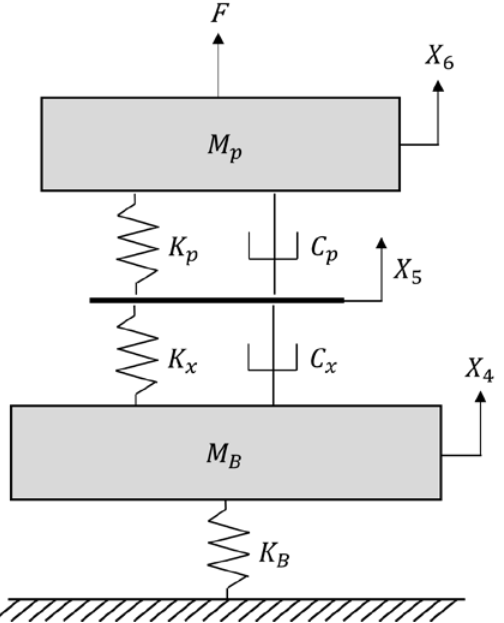
Figure 6. Equivalent system model of electric power plant supported by proposed mount module.